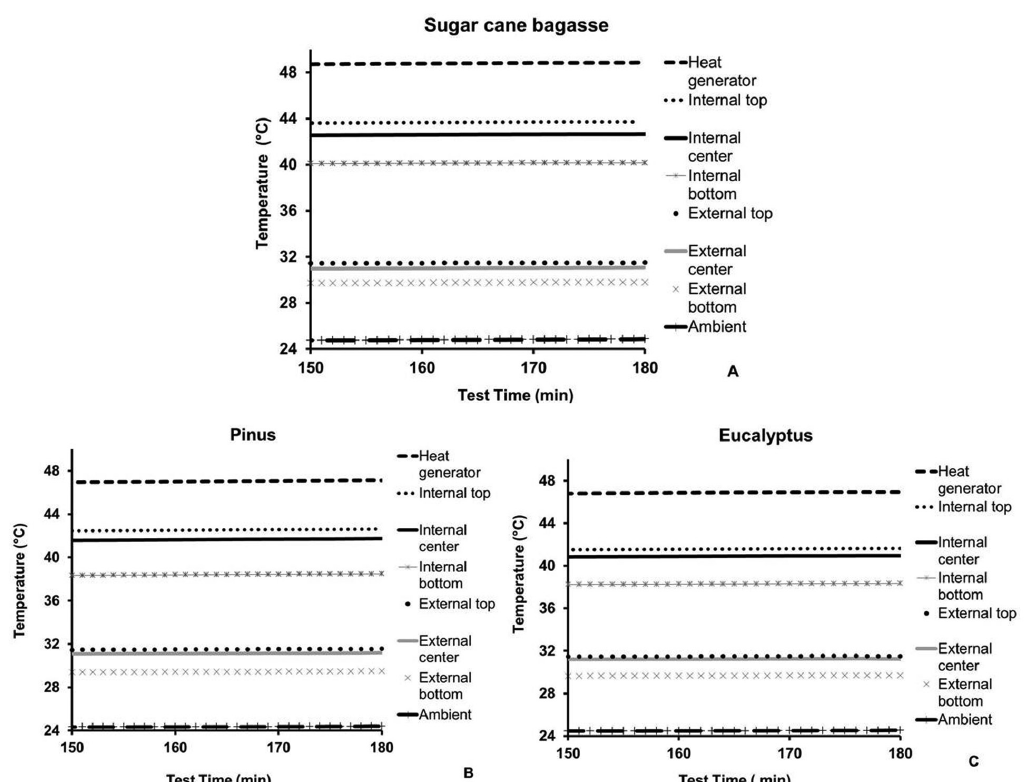
Figure 3. (A) behavior of the heat flow q “(W) throughout the test for the three types of panel, (B) behavior of the heat flow in the first 30 minutes of the test; (C) between 30 and 90 minutes of testing; (D) between 90 and 180 minutes of testing.